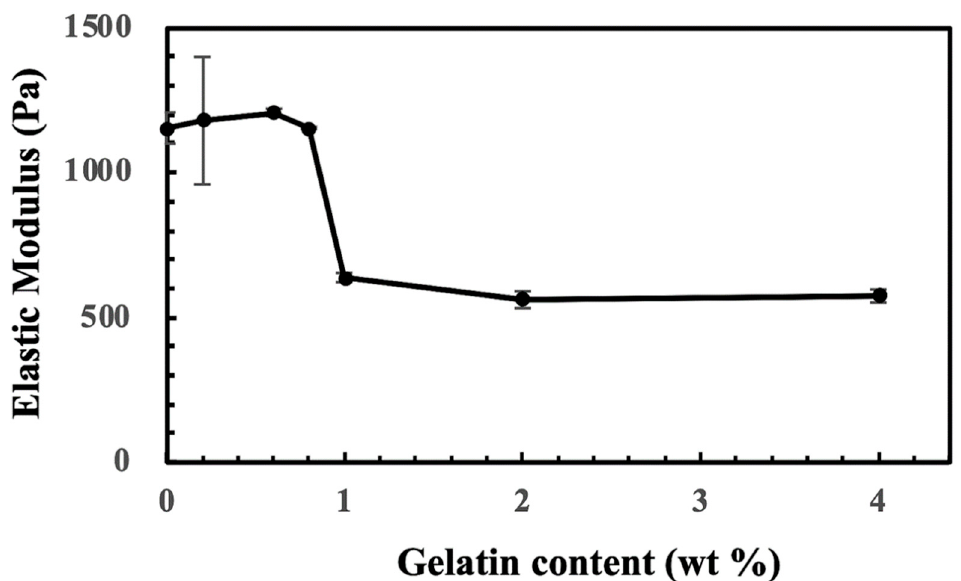
Figure 9. The elastic moduli of CS-Tyr/gelatin hydrogels, containing 4% CS-Tyr and 0–4% of gelatin. n = 3, error bars represent standard deviations.